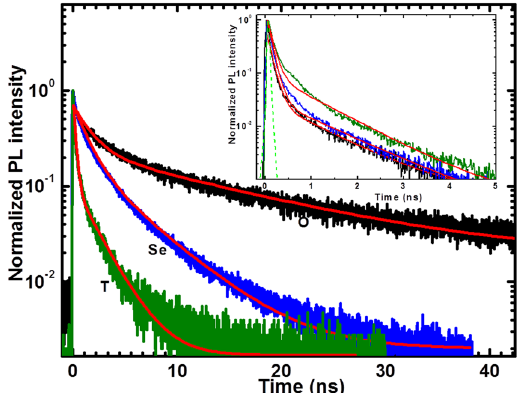
Figure 4. Time-correlated single photon counting fluorescence measurements for PBDTfDTBX:PC[70]BM blends, where X = O (black), T (olive) and Se (blue). The corresponding PBDTfDTBX (X = O, T(S), Se) polymer fluorescence decays are shown in the